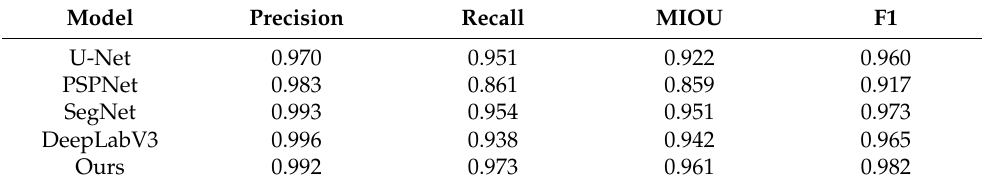
Table 3. Segmentation performance of different segmentation